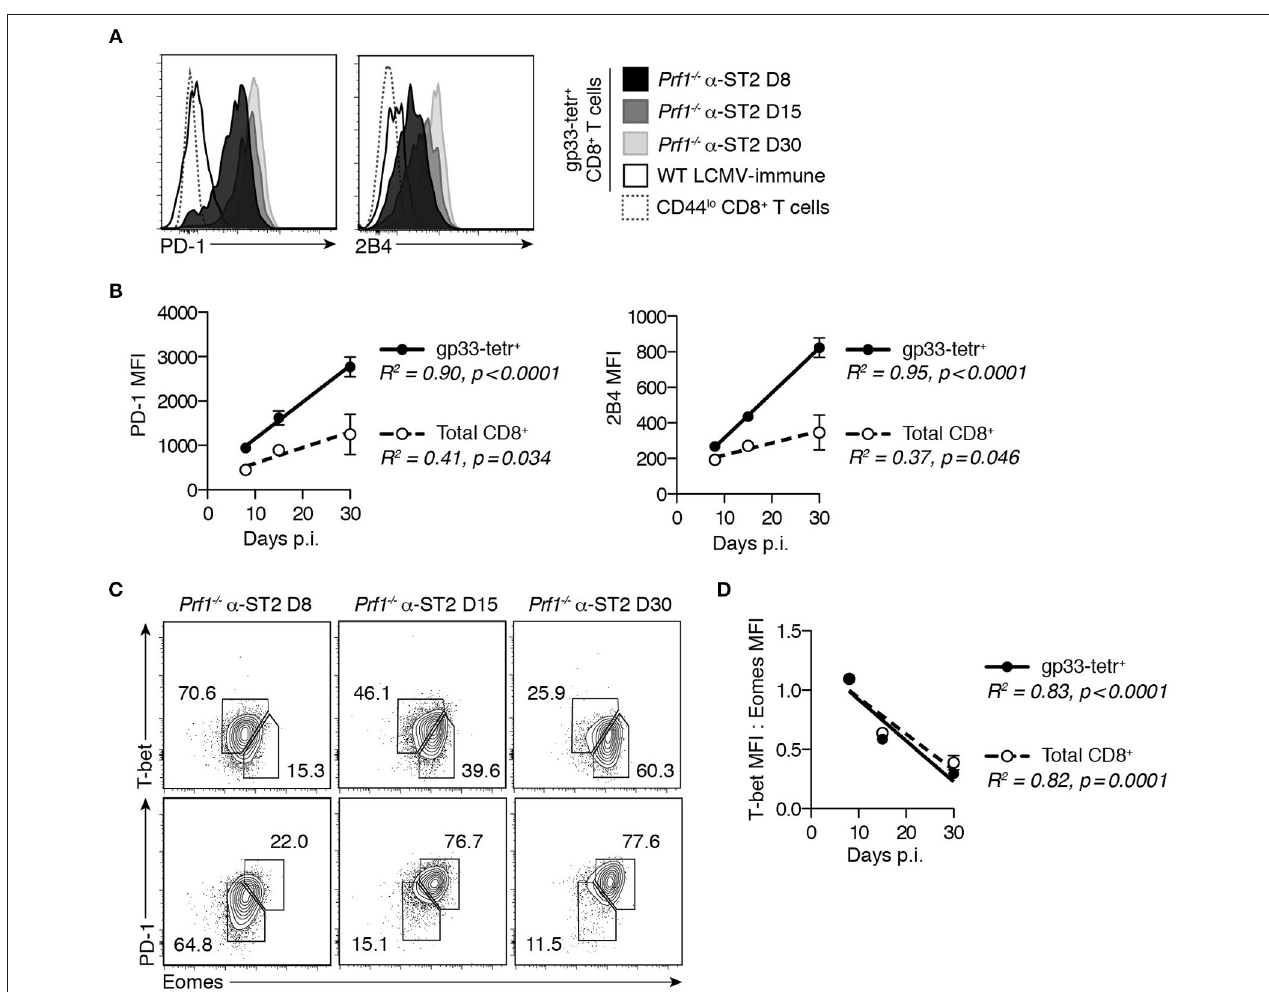
FIGURE 1 | Prf1 − / − gp33-specific CD8 + T cells develop phenotypic hallmarks of exhaustion in the setting of ST2 blockade. Prf1 − / − mice were infected with LCMV and treated every other day with α -ST2 antibody beginning on day 3 p.i. Splenocytes were assessed on days 8, 15, or 30 p.i. WT mice infected with LCMV and analyzed 30 days p.i. provided an LCMV-immune control. N = 3–4 mice/group. (A) Representative histograms gated on gp33-tetramer + CD8 + T cells, showing expression of inhibitory markers. (B) MFI of PD-1 and 2B4 in gp33-tetramer + (filled symbols) and total (open symbols) CD8 + T cells over time. Symbols represent mean ± SEM of 3-4 mice. Analyzed by linear regression. (C) Representative flow plots gated on gp33-tetramer + CD8 + T cells, showing expression of T-bet, Eomes, and PD-1. Numbers indicate the frequency of cells within the adjacent gate. (D) Ratio of T-bet MFI to Eomes MFI in gp33-tetramer + (filled symbols) and total (open symbols) CD8 + T cells over time. Symbols represent mean ± SEM of 3–4 mice. Analyzed by linear